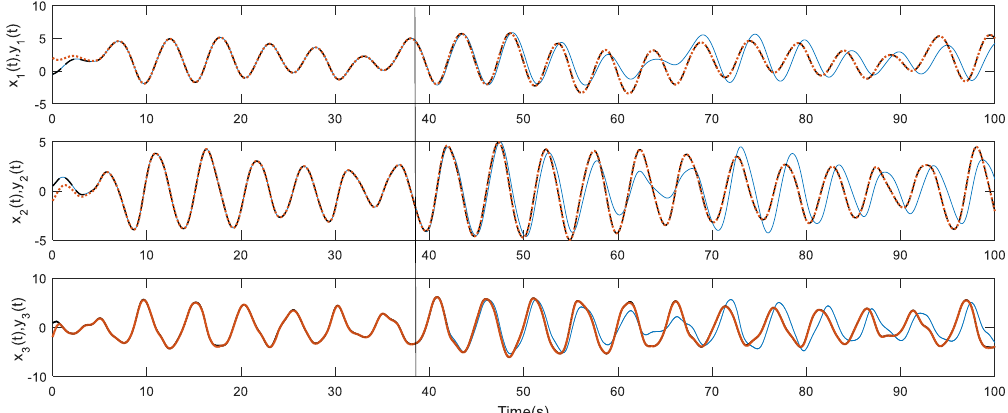
Figure 8. The robust synchronization presses of systems (25), (26) with unknown variable time delays based on the proposed adaptive control strategy where it is activated at 𝑡 = 5 s . Solid linesare the dynamics of the master system for 𝜏 1 = 0.45 , dashed-dotted lines are the dynamics of the master system based on step-change 𝜏 1 = 0.45 to 𝜏 1 = 0.5 at 𝑡 = 38.45 s , and dotted lines are the dynamics of the slave system based on step-change 𝜏 2 = 0.1 to 𝜏 2 = 0.7 at 𝑡 = 38.45 s .